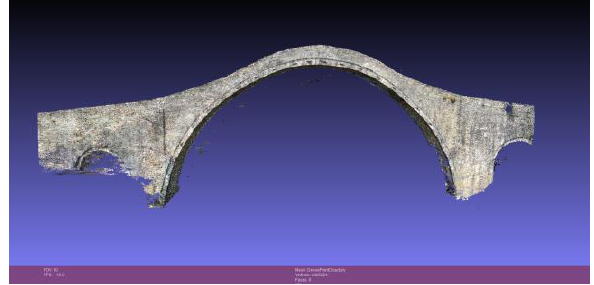
Figure 8: Dense point cloud produced in Agisoft PhotoScan – 56 images.